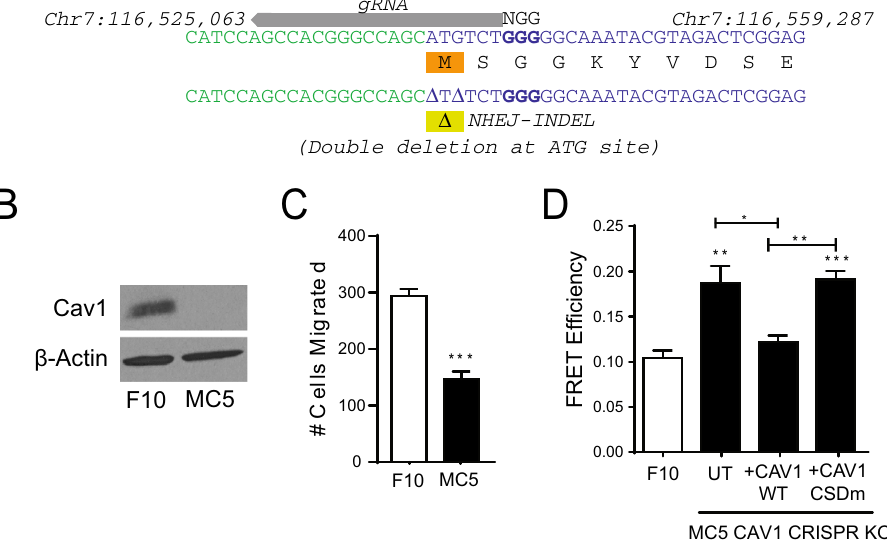
Figure 2. CAV1 CRISPR knockout from F10 sub-clone. ( A ) Schematic of the gRNA designed to target the ATG start site of the CAV1 sequence. ( B ) Western blot of CAV1 in MC5 CRISPR/CAS9 knockout and F10 sub- clone used to generate MC5. ( C ) Bar graphs of mean ± SEM of cells migrated between parental F10 and MC5 quantified from Transwell migration assays (n = 5; two-tailed unpaired t test; *** p < 0.001). ( D ) Vinculin FRET efficiency of F10 parental line and MC5 rescued with CAV1 wildtype and the CSD mutant (n = 3; ANOVA with Tukey post-test; * p < 0.05; ** p < 0.01). See Supp. Fig. 5 for complete blots that were cropped for Fig.